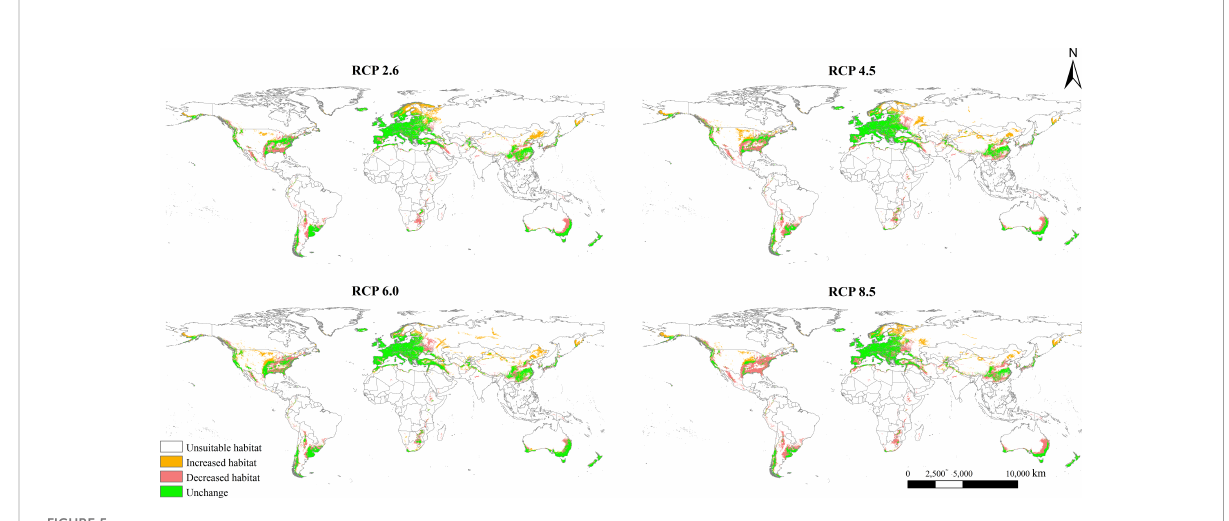
FIGURE 5 Spatial changes in Lolium temulentum distribution under future climate scenarios, including RCP 2.6, RCP 4.5, RCP 6.0, and RCP 8.5.